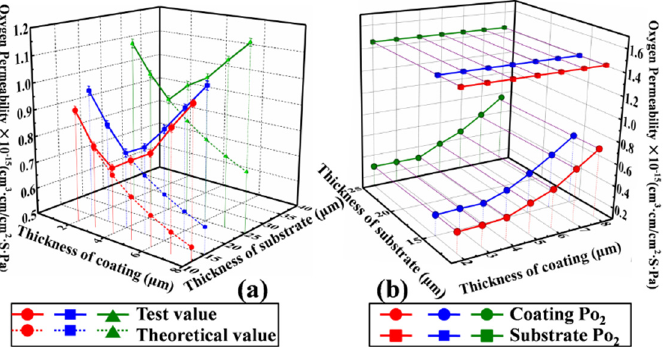
Figure 7. The effect of coating thickness on the oxygen barrier property: ( a ) theoretical and test P o 2 of PET films coated by with different thicknesses; ( b ) P o 2 of substrate, coatings with different MMA-MAc-DAM-MA coating thicknesses.